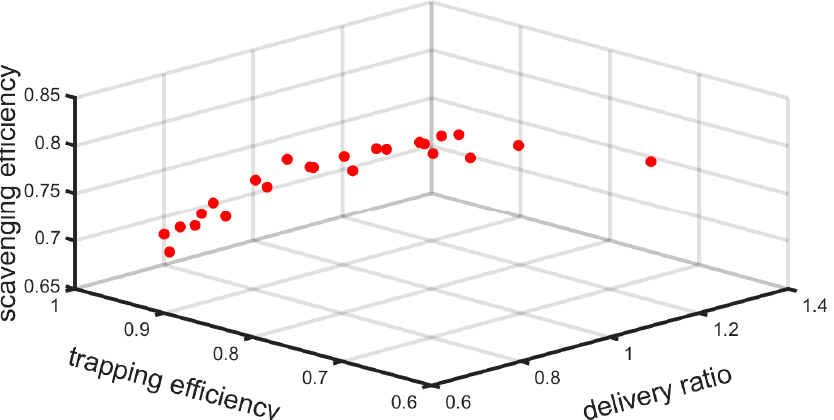
Figure 14. 3D Pareto front results of the high load operating condition.